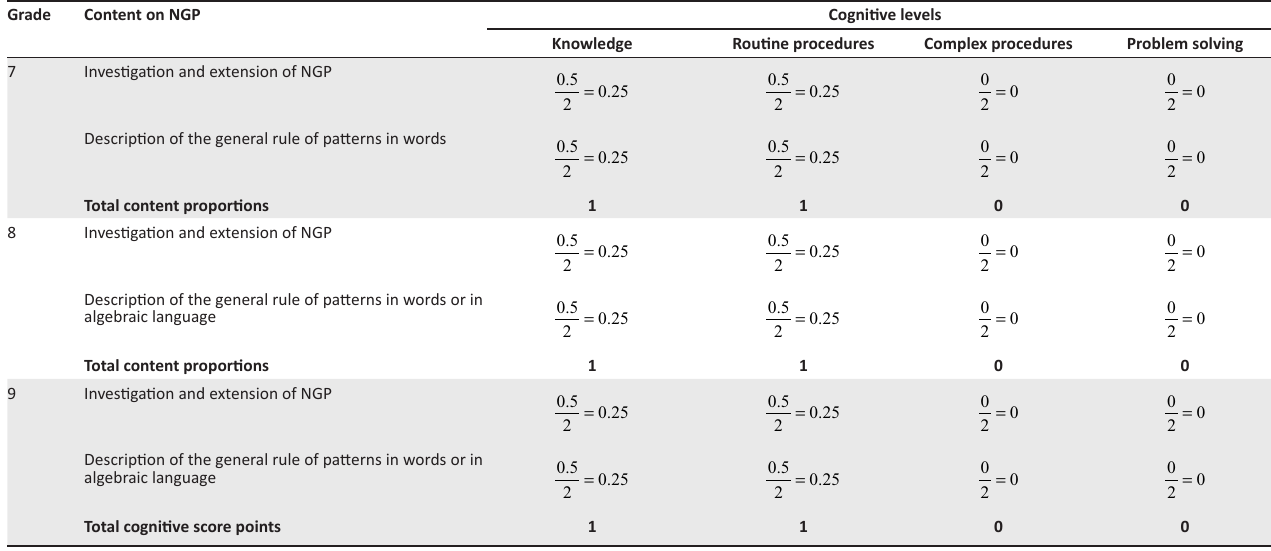
TABLE 4: Grades 7–9 SPMCS